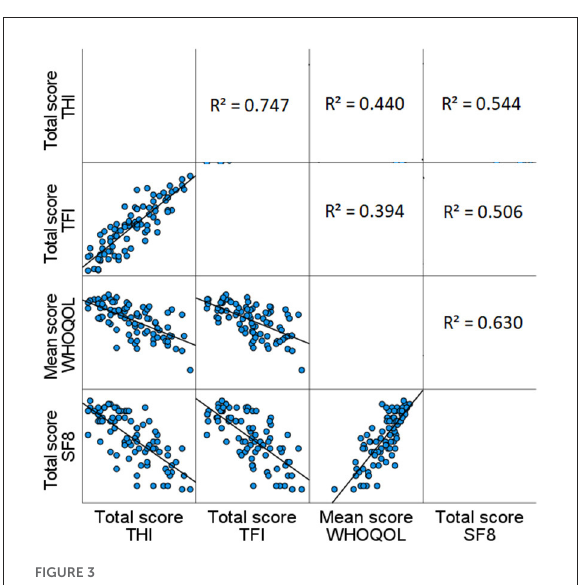
FIGURE3 Scatterplots and determination coefficients of TFI, THI, WHOQOL-BREF, and SF-8. The scatterplots and determination coefficients ( R 2 ) show the strength of the regressions between the TFI, THI, WHOQOL-BREF, and SF-8. In the left corner below, the scatterplots are presented, whereas the determination coefficients are shown in the top right